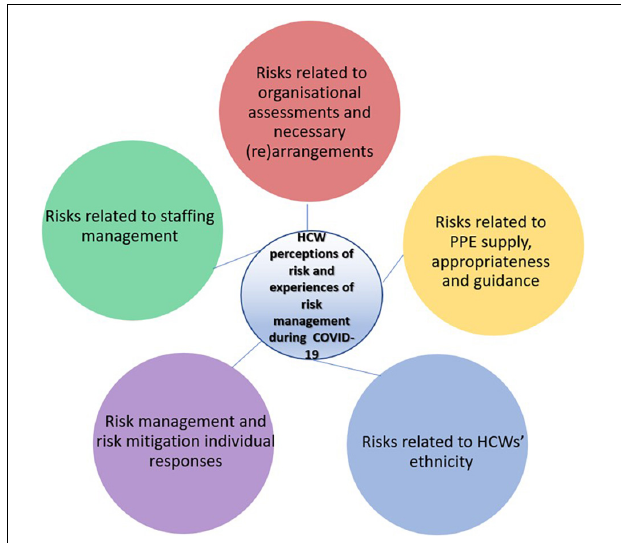
FIGURE 1 | Summary of findings